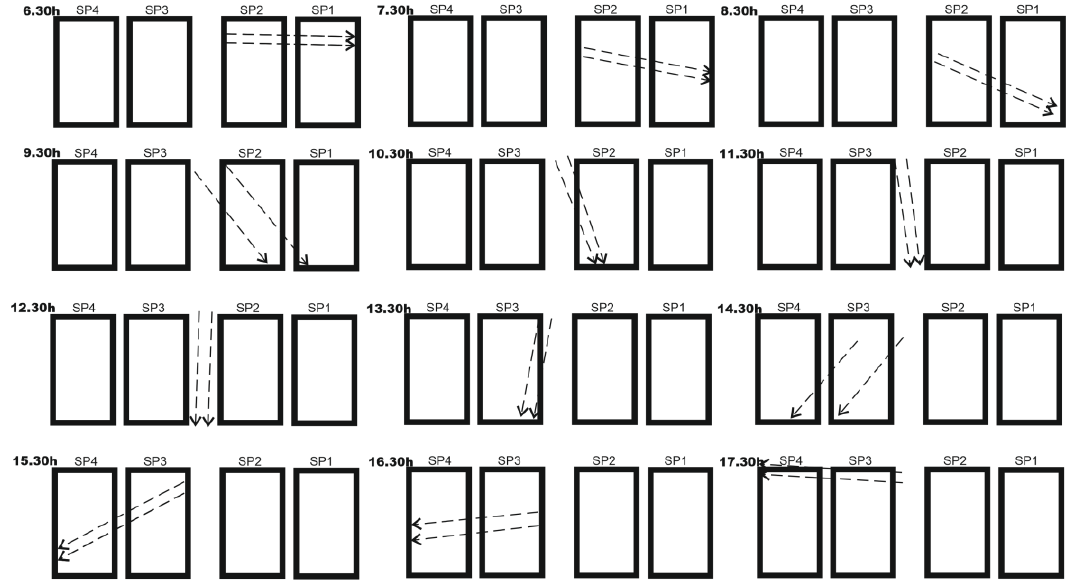
Figure 16. Daily partial shading displacement by the hour.